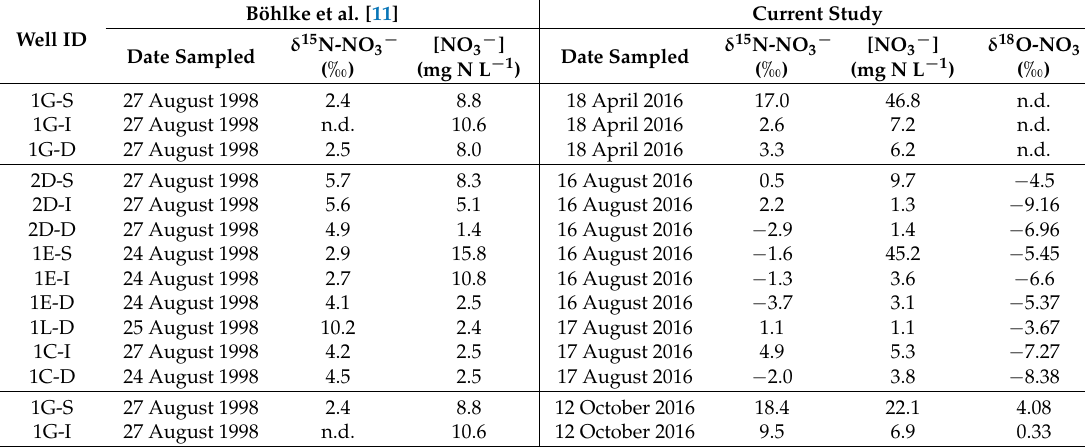
Table 2. Nitrate nitrogen and nitrogen isotopic ratio of nitrate from samples collected in 1998 and compared to 2016 samples, at well nests where age-dating was also conducted. Samples collected in 2016 were mostly analyzed for δ 18 O-NO 3 − , as